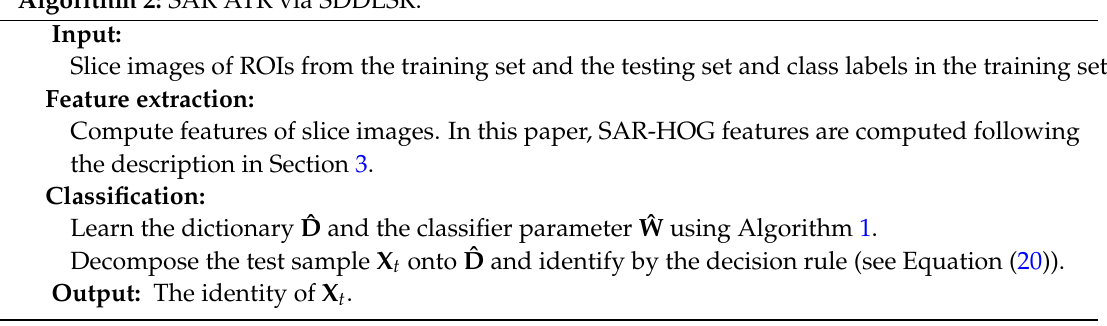
Algorithm 2: SAR ATR via